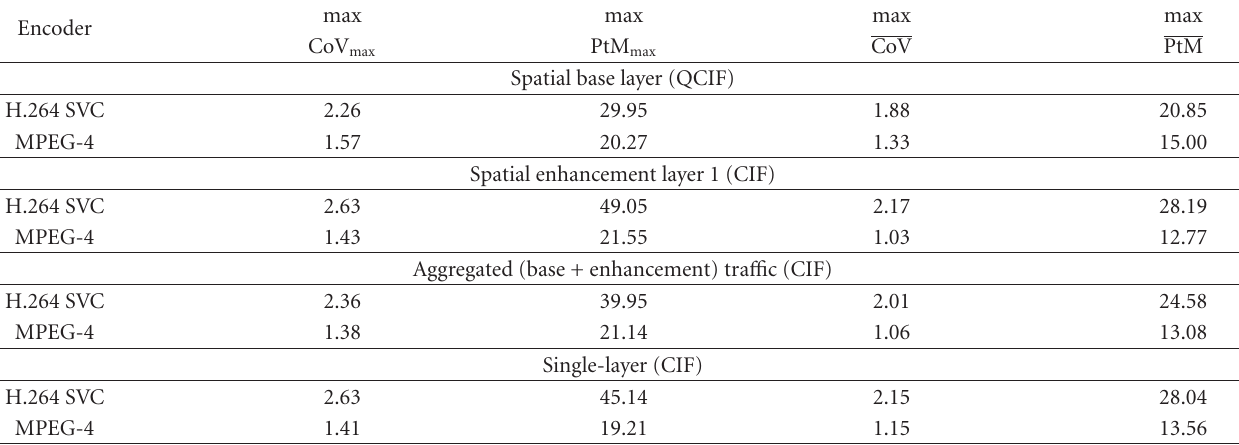
Table 5: Maximum (across quantization scales) of maximum (across five video sequences), and maximum of mean CoV and PtM values of H.264 SVC and MPEG-4 Part 2 spatial base and enhancement layers, and aggregated tra ffi c.